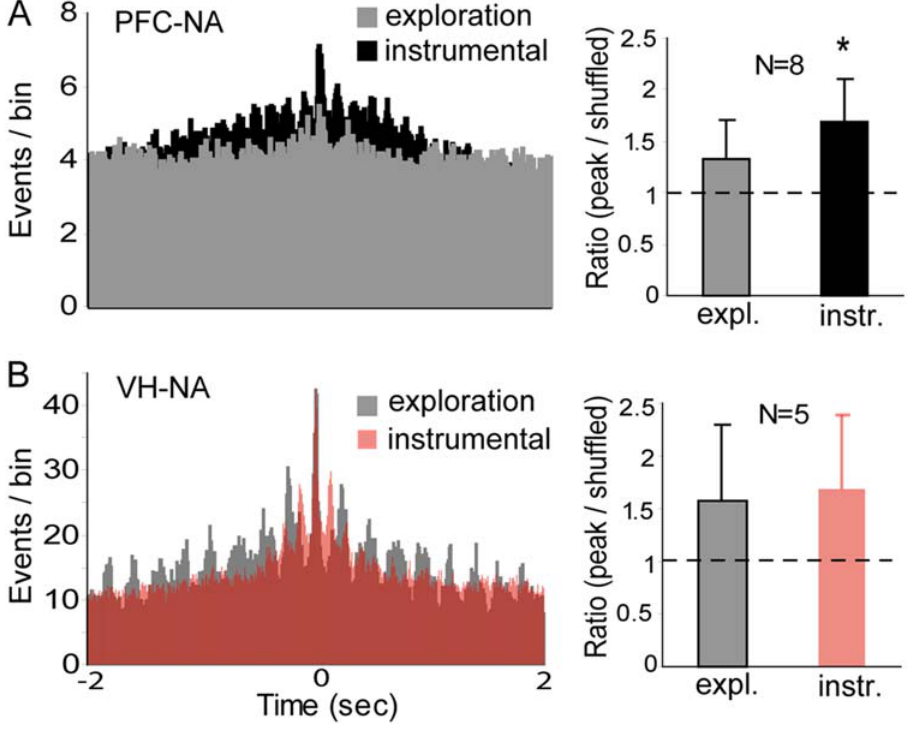
Figure 1. PFC-NA unit correlation is strengthened during bar press for a natural reward. (A) Representative cross-correlograms of a NA- PFC neuron pair (referenced to PFC firing at time 0) when the animal was exploring (gray) and during bar pressing for sucrose (black). Right: bar graphs showing the ratio between the crosscorrelogram peak and a similar analysis of shuffled recordings from the same pairs for both behavioral conditions. Mean 6 SD; * p , 0.05 by paired t test. (B) Similar cross-correlation of a representative VH-NA pair during exploration (gray) and bar pressing (red). No differences were observed in these cases.